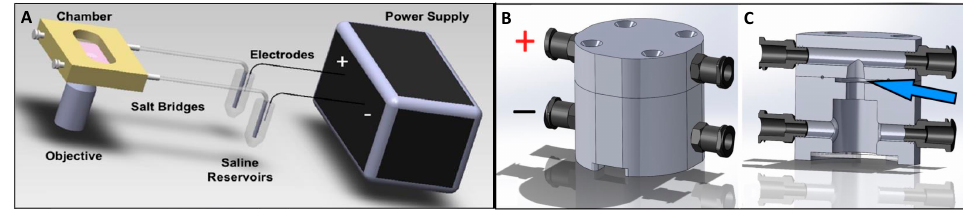
Figure 2. ( A ) Schematic of classic 2D galvanotaxis system. Cells are plated on a glass slide within a custom chamber and exposed to EF gradient for three hours. ( B , C ) Design of novel 3D galvanotaxis chamber with denoted electrode positions (+ and − ). The system allows EF gradients to be applied to 3D tissues and constructs (blue arrow denotes sample placement within the chamber).